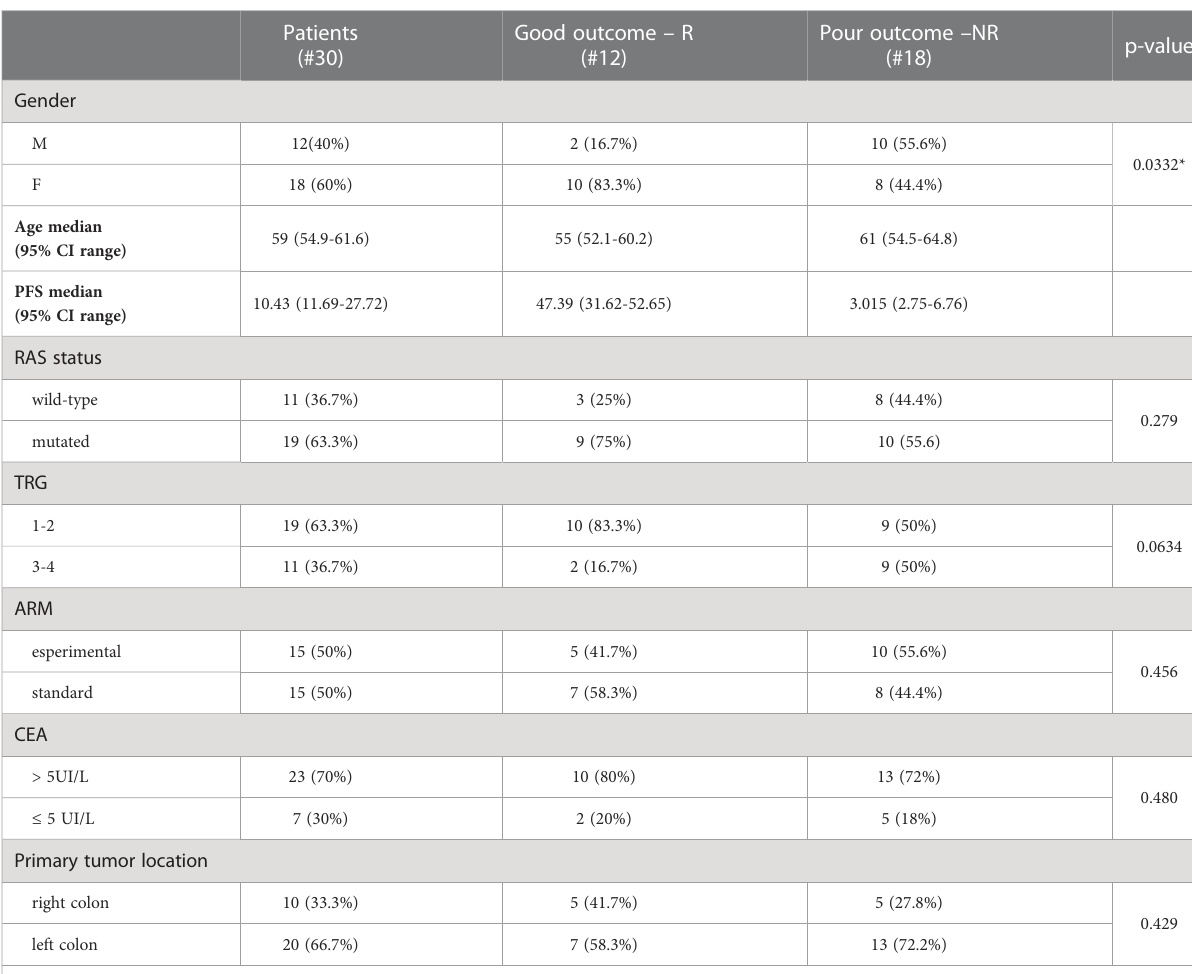
TABLE 1 Baseline characteristics of 30